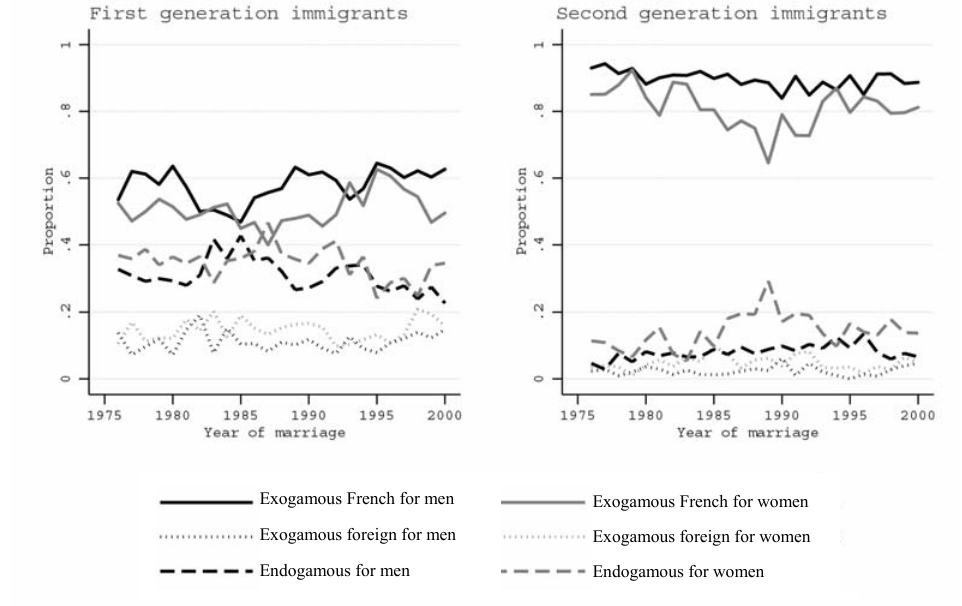
Figure 2: Evulution of types of immigrant marriage in France Evolution of types of marriages for second generation immigrant men and